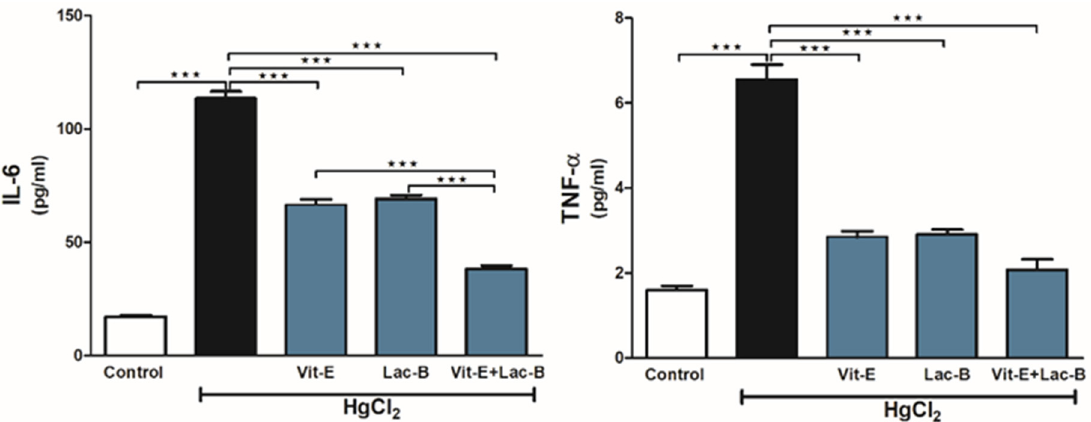
Figure 5. Vit-E and Lac-B attenuated HgCl 2 -induced renal inflammation in rats. Treatment with Vit-E and Lac-B either alone or in combination decreased renal inflammatory biomarkers (IL-6 and TNF- α ). Data are expressed as mean ± SEM, ( n = 6). *** p < 0.001.